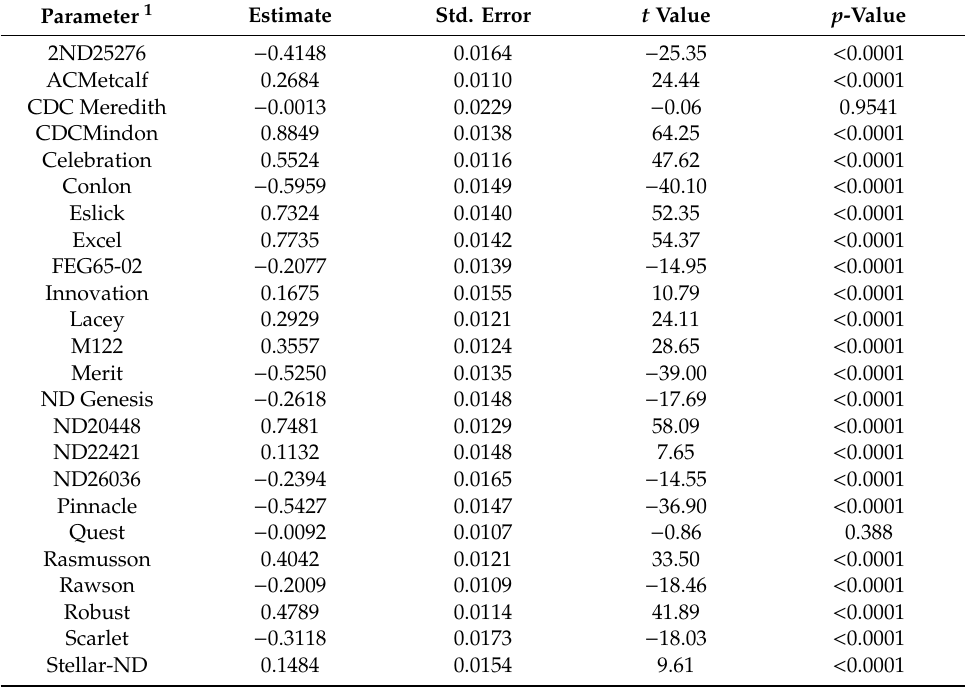
Table 4. Estimated intercept coe ffi cients, interaction terms with cultivars and fungicide application.